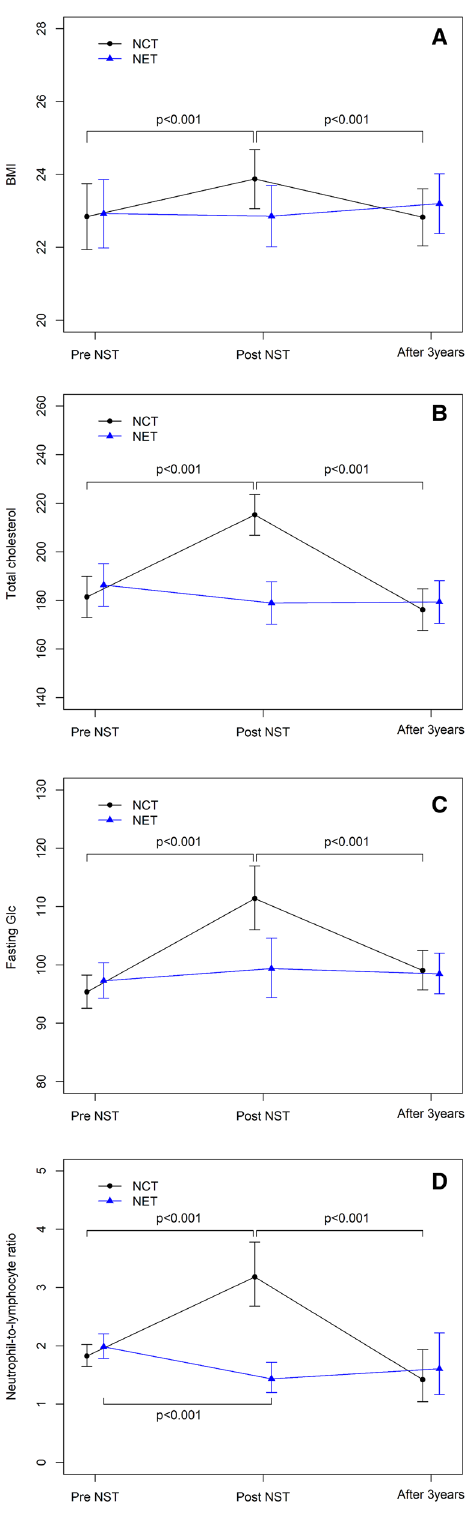
Figure 1. Metabolic profile and NLR changes after NST and 3 years after the initial treatment. ( A ) BMI change during NCT and NET. ( B ) Total cholesterol change during NCT and NET. ( C ) Fasting glucose change during NCT and NET. ( D ) NLR change during NCT and